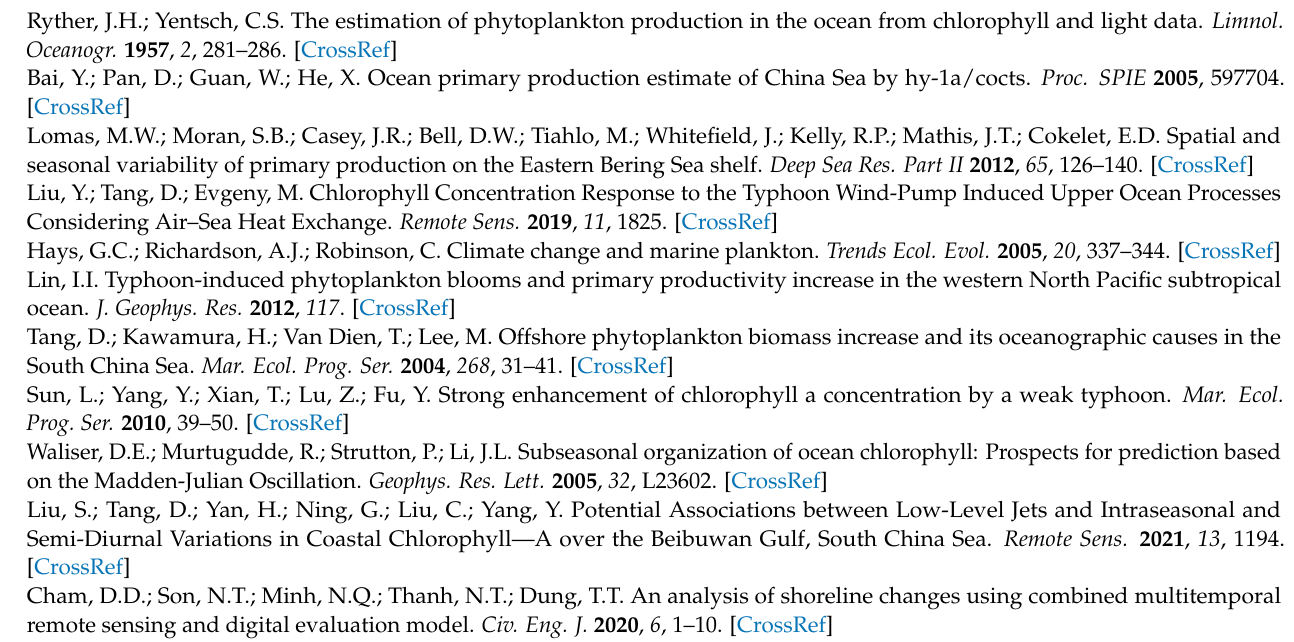
Figure 3d (Regions A and C). (a) Ekman transport in X direction in Region A; (b) Ekman transport in X direction in Region C; (c) Ekman transport in Y direction in Region A; (d) Ekman transport in Y direction in Region C., Figure S7: Mean wind speed at 10 m (shaded, m s − 1 ) in four synoptic types: (a) Type 1; (b) Type 2; (c) Type 3; (d) Type 4.; Figure S8: Mean PAR (shaded, µ mol m − 2 s − 1 ) in four synoptic types: (a) Type 1; (b) Type 2; (c) Type 3; (d) Type 4.; Figure S9: Mean rainfall (shaded, mm day − 1 ) in four synoptic types: (a) Type 1; (b) Type 2; (c) Type 3; (d) Type 4.; Figure S10: Deviation percentage of chl-a concentration in Type 1 and Type 2 in summer each month. (a–c) The deviation percentage of type 1 from June, July and August respectively; (d–f) the deviation percentage of type 2 from June, July and August respectively.; Figure S11: Chl-a concentration anomaly in four synoptic types which remove typhoon effects (the gray dots cover areas with significant differences): (a) Type 1; (b) Type 2; (c) Type 3; (d) Type